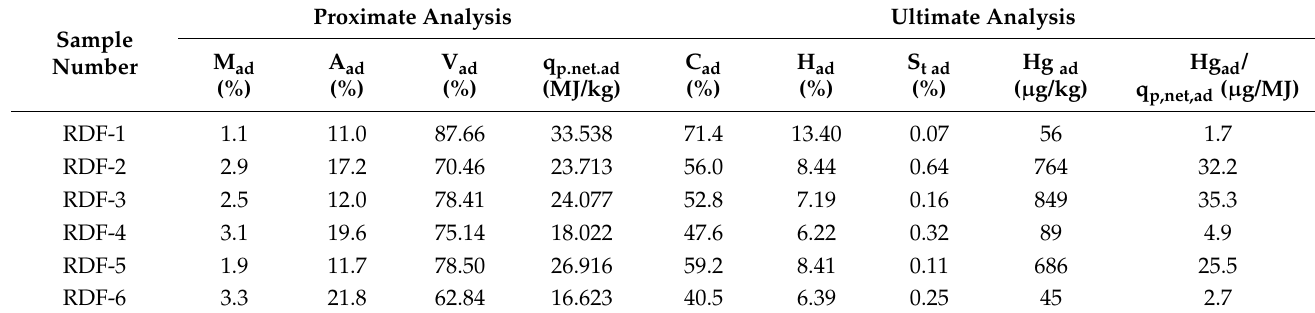
Table 3. Characteristics of the